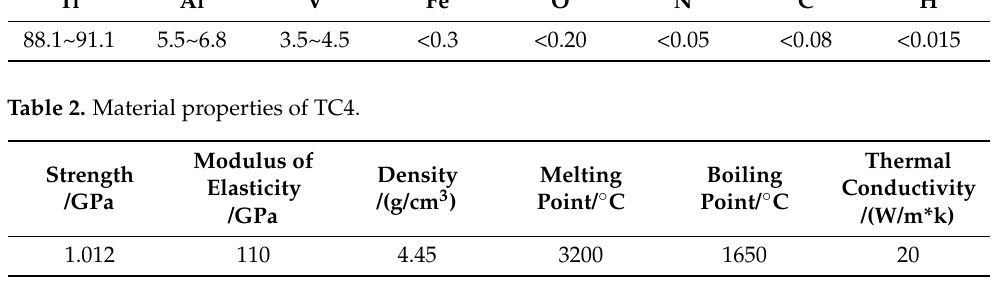
Table 1. Chemical composition of TC4.